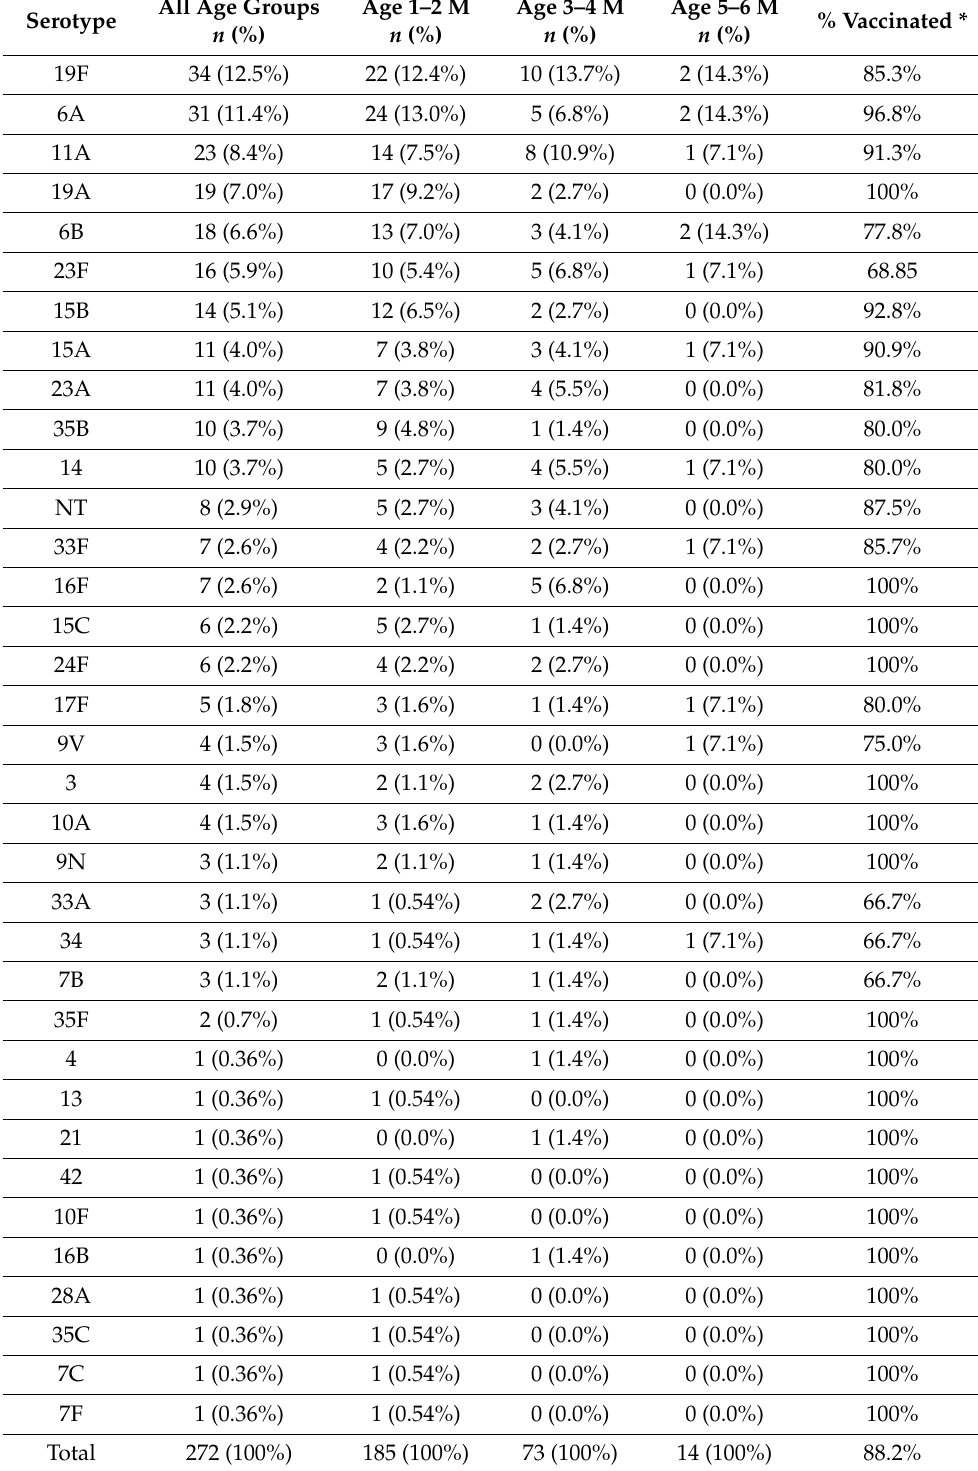
Table 2. Number of serotypes detected in each age group, and rate of vaccinated infants for each